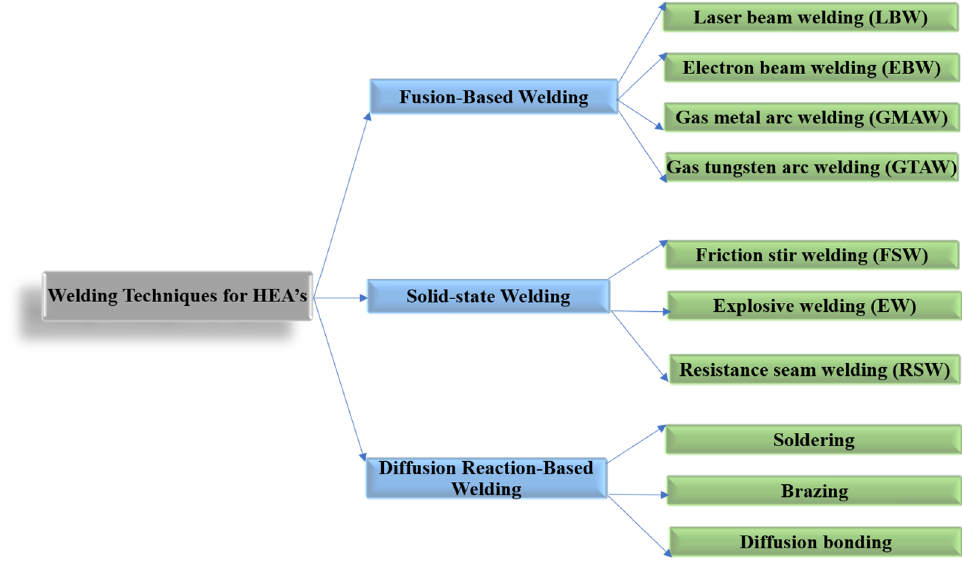
Figure 2. Welding techniques for HEAs.